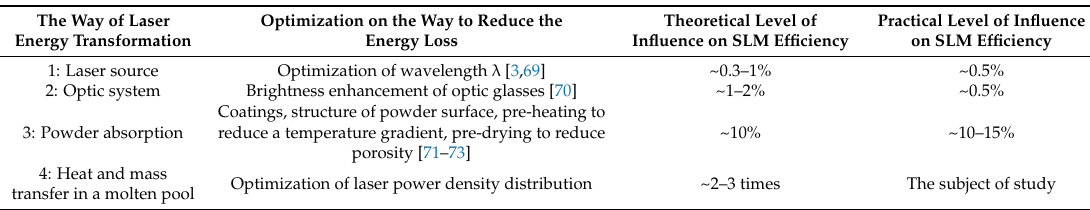
Figure 5. Classification of main SLM factors. Table 1. The way of energy transformation from the laser source to the molten pool for selective laser melting/sintering.